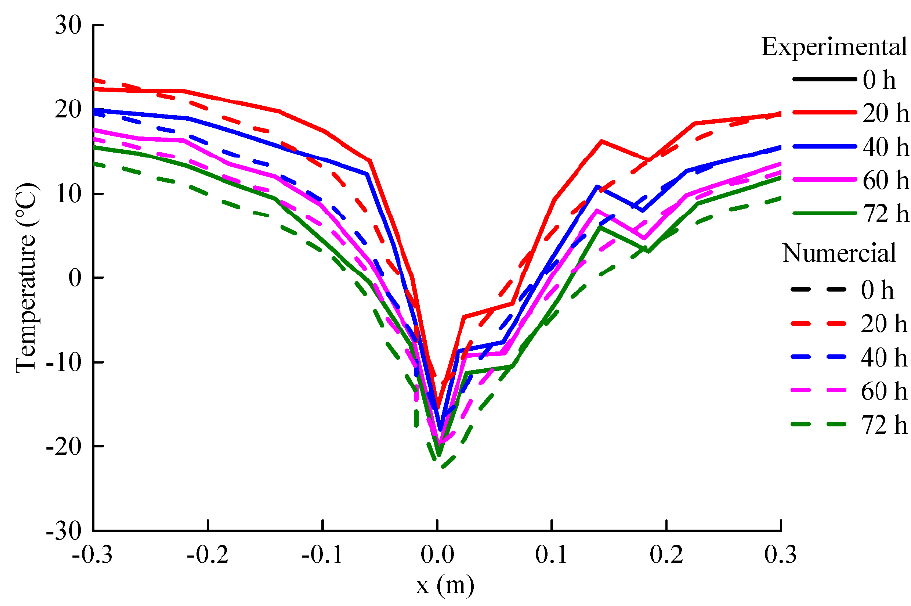
Figure 4. Comparisons between numerical solution and experimental measurements from reference [24].